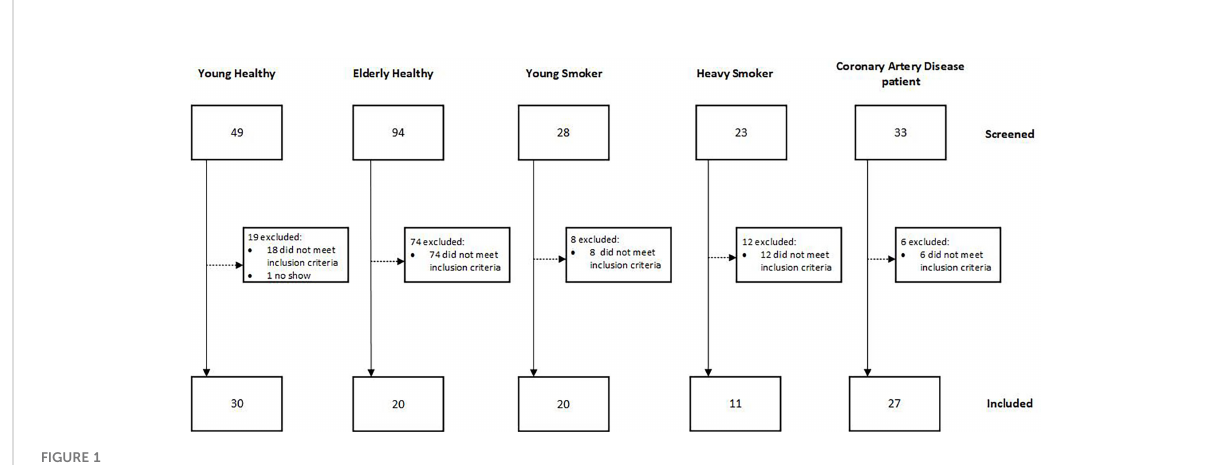
FIGURE 1 CONSORT fl